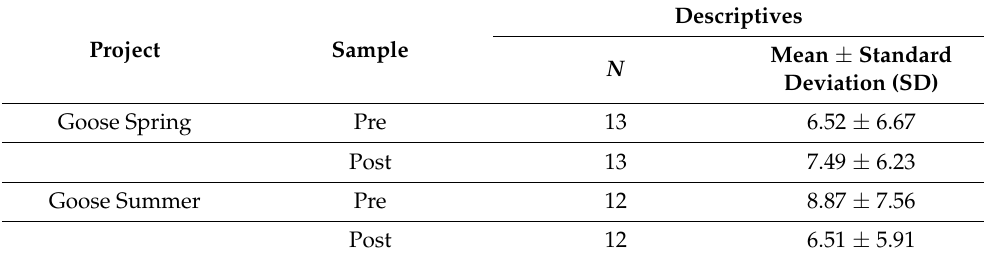
Table 1. Salivary cortisol (nmol/L) descriptives for pre- and post-participation in activities.